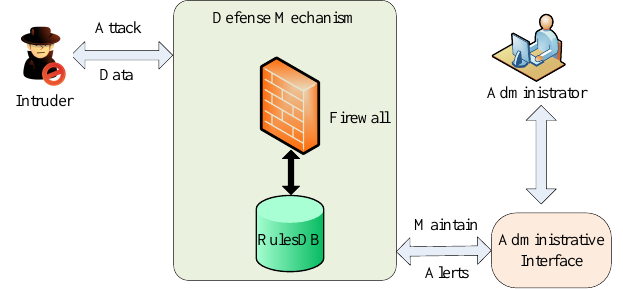
Figure 1. Defense Scenario I with firewall